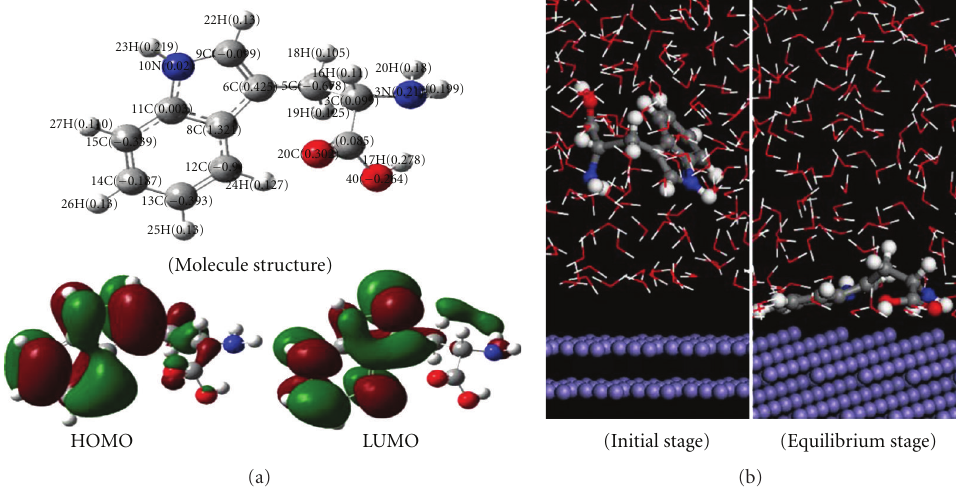
Figure 5: (a) Optimised molecule structure and charge density distribution of L-tryptophan. (b) L-tryptophan adsorbed on Fe surface in water